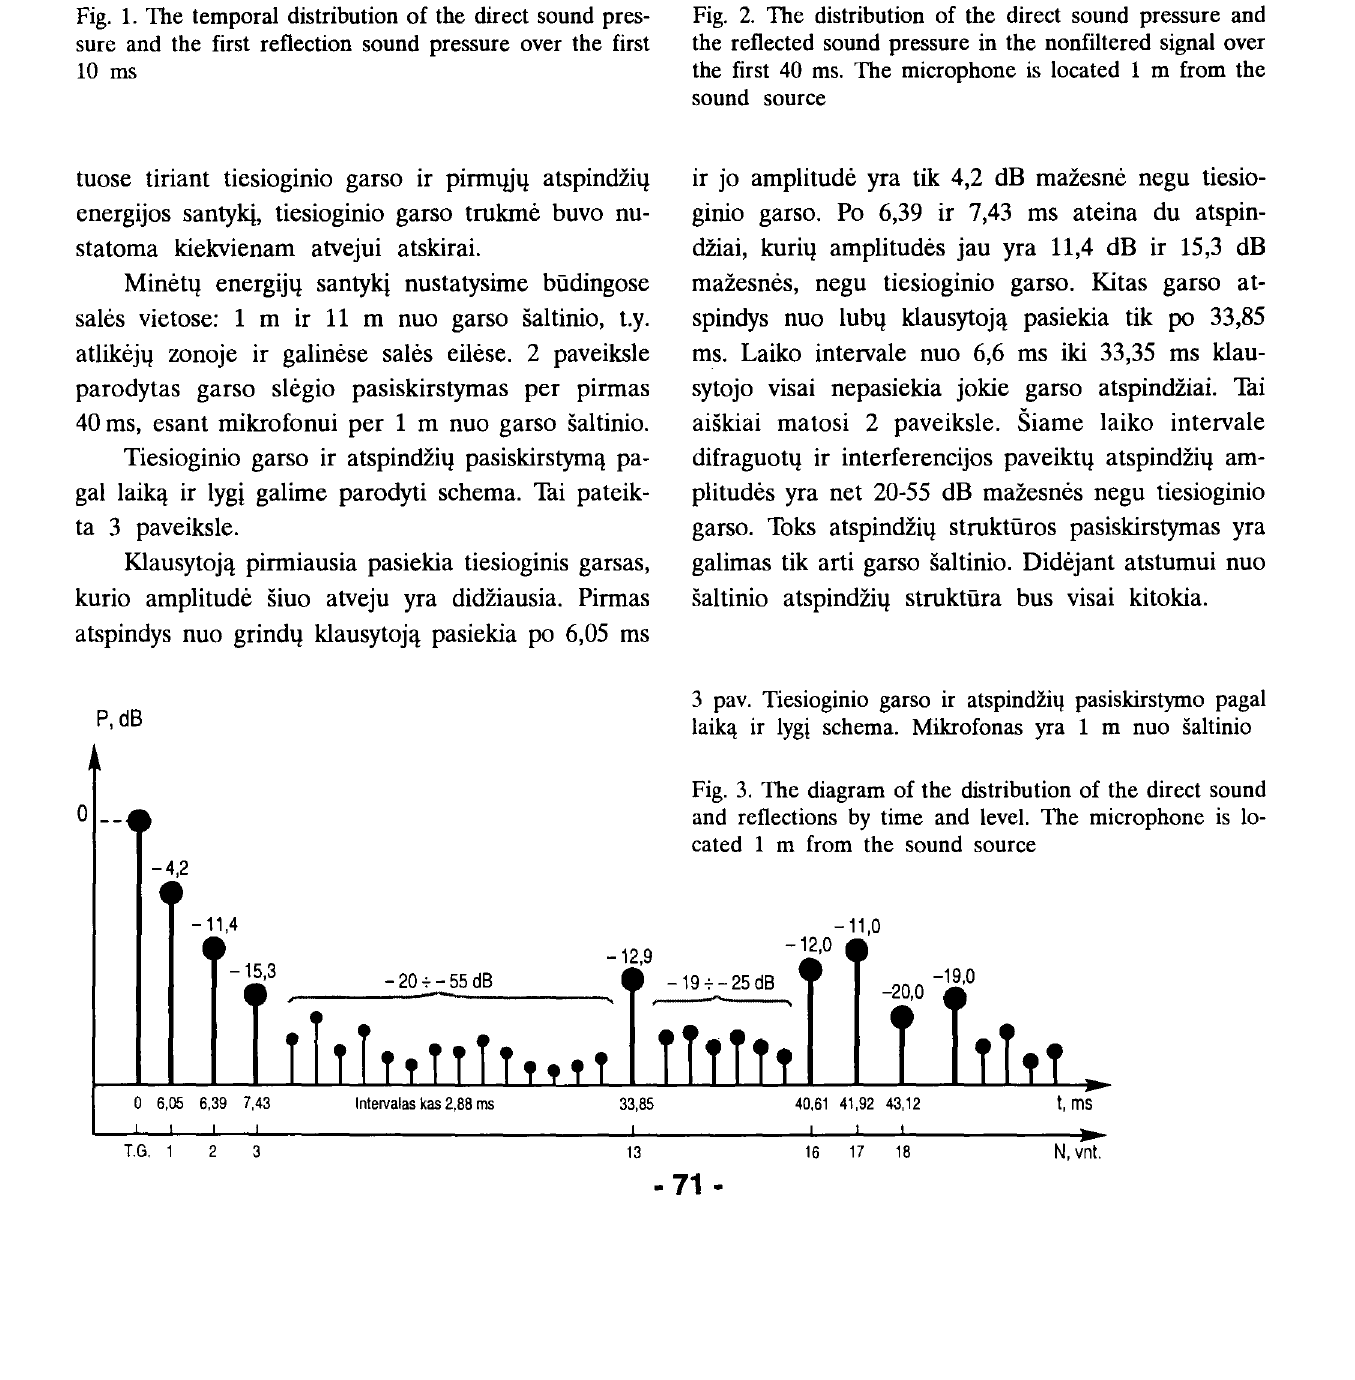
1 pav. Tiesioginio garso ir pirmo atspindzio garso slegio pasiskirstymas pagal laikq per pinnas 10 ms Fig. 1. The temporal distribution of the direct sound pres